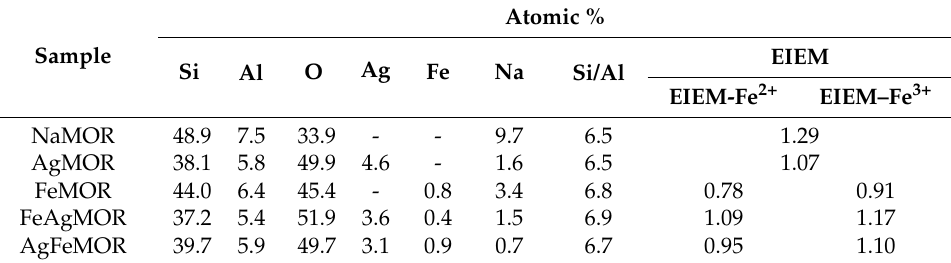
Table 2. Chemical composition of the samples, measured by